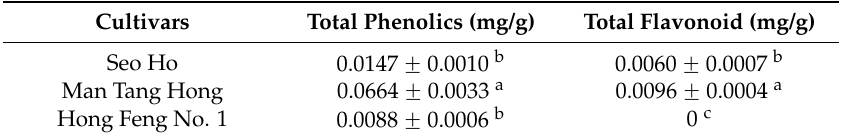
Table 2. Total polyphenolics and flavonoid contents of ethanol extract from Raphanus sativus .